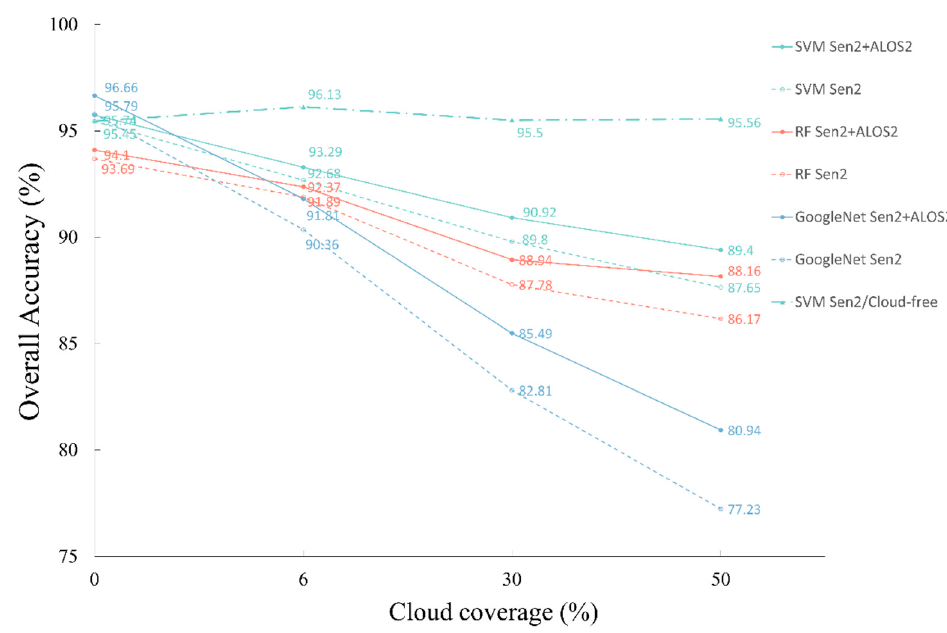
Figure 5. The overall accuracy of three classifiers under different cloud coverage using single optical data and combined optical and SAR data.